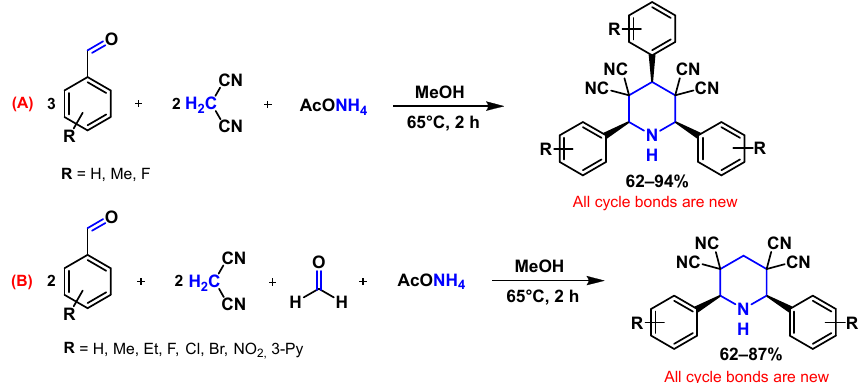
with three ( A ) and two ( B ) aromatic